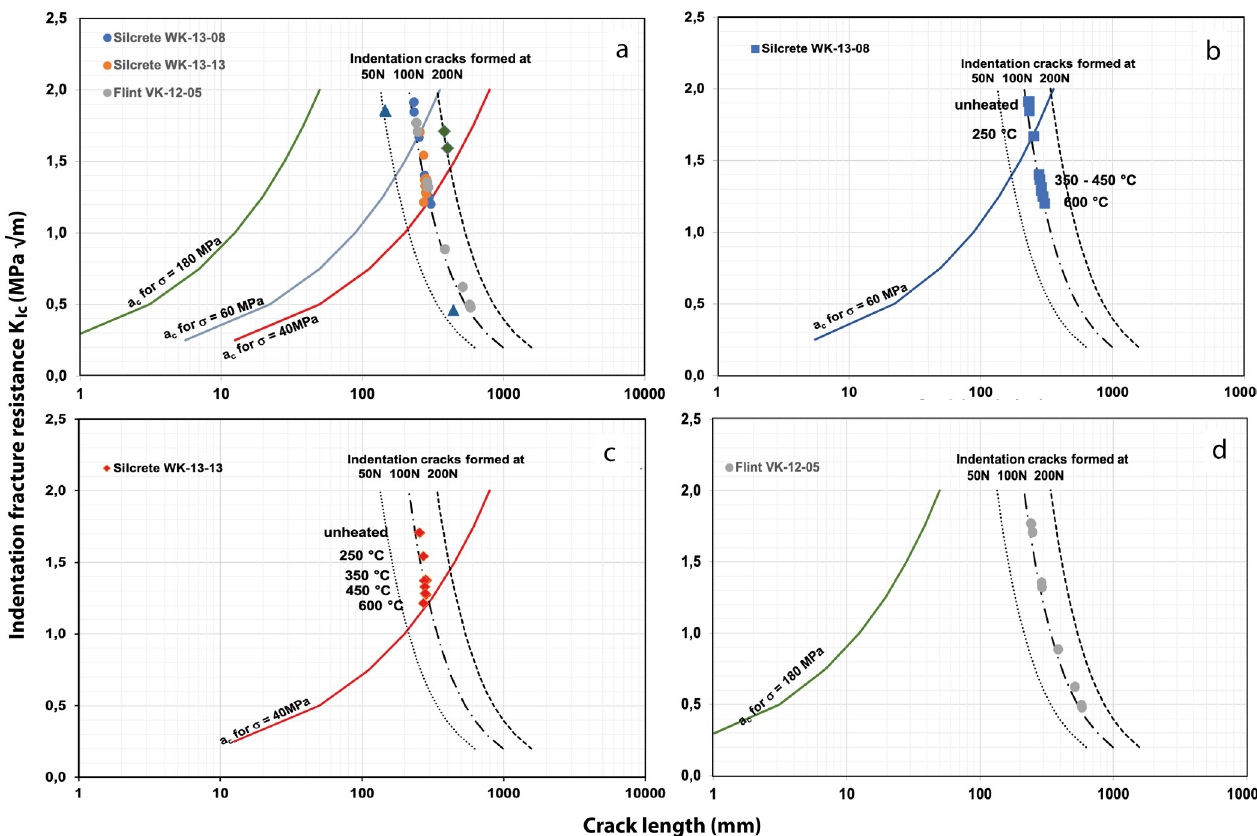
Fig 2. Diagrams reporting crack length as a function of indentation fracture resistance. Two sets of lines are displayed: critical flaw sizes for a given uniaxial tension stress from Griffith Eq (8) and fits of indentation crack length from Eq (4) for a given indentation force. A more detailed explanation can be found in the main